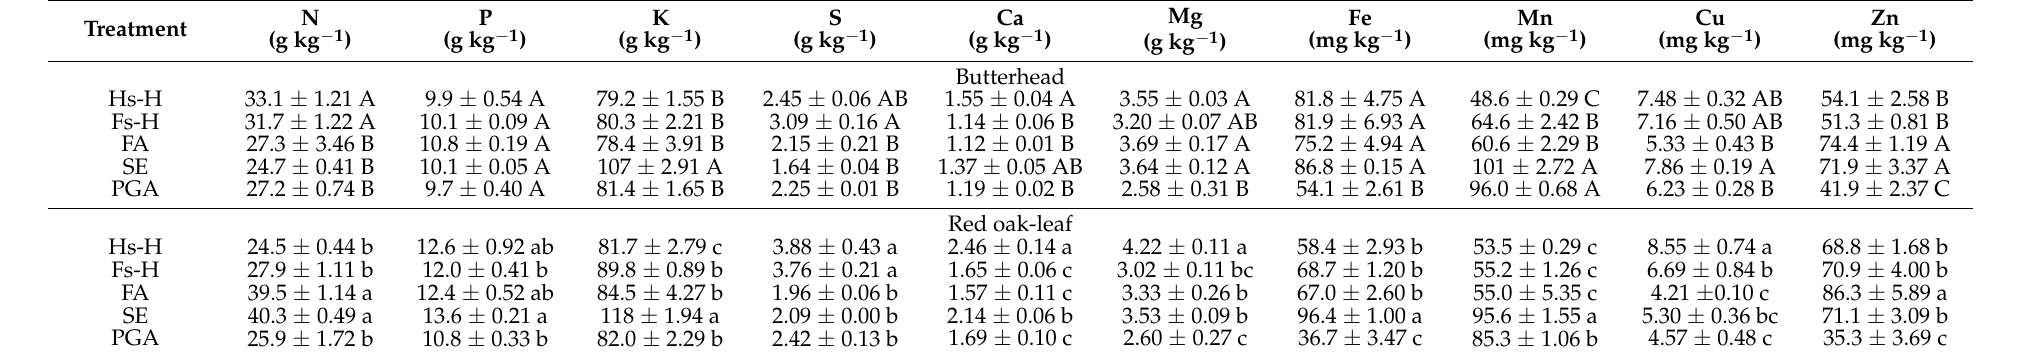
Table 3. Macro and micronutrient concentration in the shoot of butterhead and red oak-leaf lettuce. Data represent mean ± SD ( n = 3). Means within each column followed by different uppercase and lowercase letters are significantly different for butterhead and red oak-leaf ( α = 0.05). Treatment